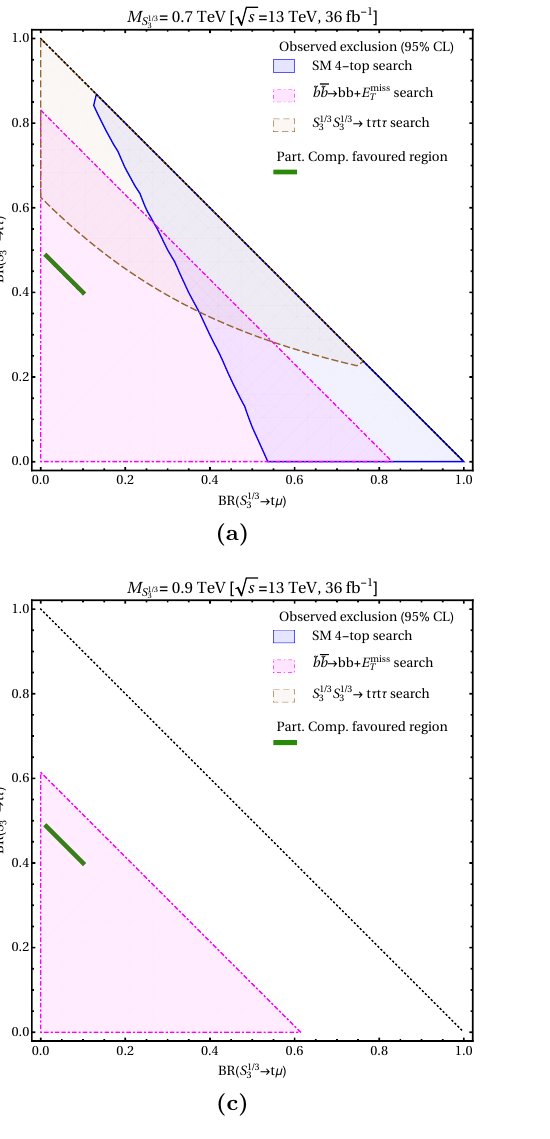
Figure 1. Bounds on the S 1 = 3 leptoquark branching ratios into t(cid:28) , t(cid:22) , and b(cid:23) , derived from recent 3 p LHC searches based on 36 fb (cid:0) 1 of pp collisions at s = 13 TeV, for di(cid:11)erent values of the leptoquark mass M : (a) 0.7 TeV, (b) 0.8 TeV, (c) 0.9 TeV, and (d) 1 TeV. Also shown is the region preferred S 1 = 3 3 by our partial compositeness model. The area above the diagonal line corresponds to the unphysical region where the sum of branching ratios exceeds unity, or is smaller than zero.